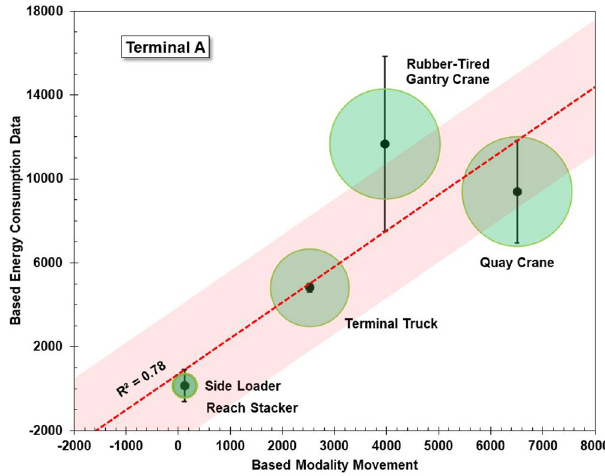
Figure 12. Robustness of the CO 2 emission calculation model for terminal A.